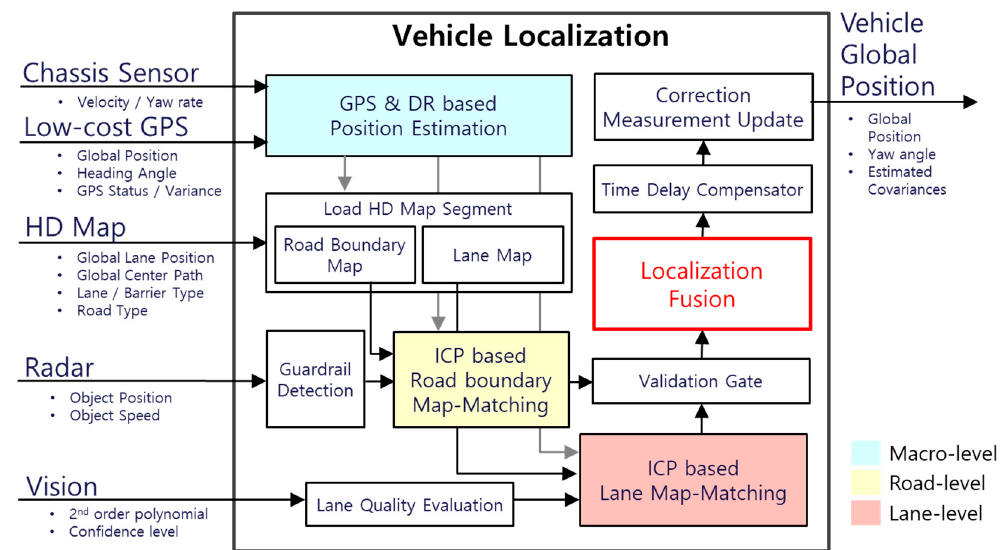
Figure 2. Localization algorithm architecture. Global Positioning System(GPS), High Definition(HD), Iterative Closest Point (ICP), Dead Reckoning(DR). Table 1. Noise specifications of proprioceptive sensors.